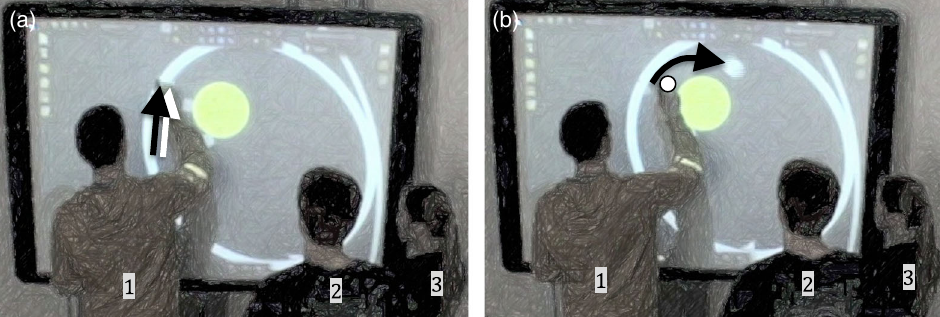
FIG. 1. A student throwing a planet into an orbit around the Sun. In (a) the white arrow represents the path that the student ’ s hand traveled and the black arrow represents the path that the planet traveled. The paths overlap in (a) (the student was dragging the planet before he released it). In (b), the planet starts to orbit on a curved trajectory after the student released it by retracting the stylus from the IWB surface. The student ’ s hand remains in the same place where he released the planet (the position of the hand is represented by the white dot).